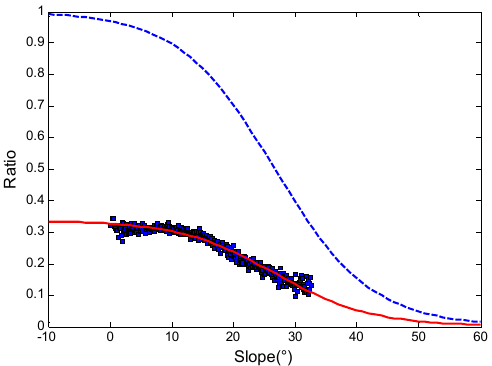
Figure 8. Regression graph of the damaged pine distribution ratios in different slope values. The abscissa was slope value and the ordinate was the ratio of severely damaged pine forest (RVI < 4, with more caterpillars) to all pine forests in a specific slope value in 2000. Points were counted.